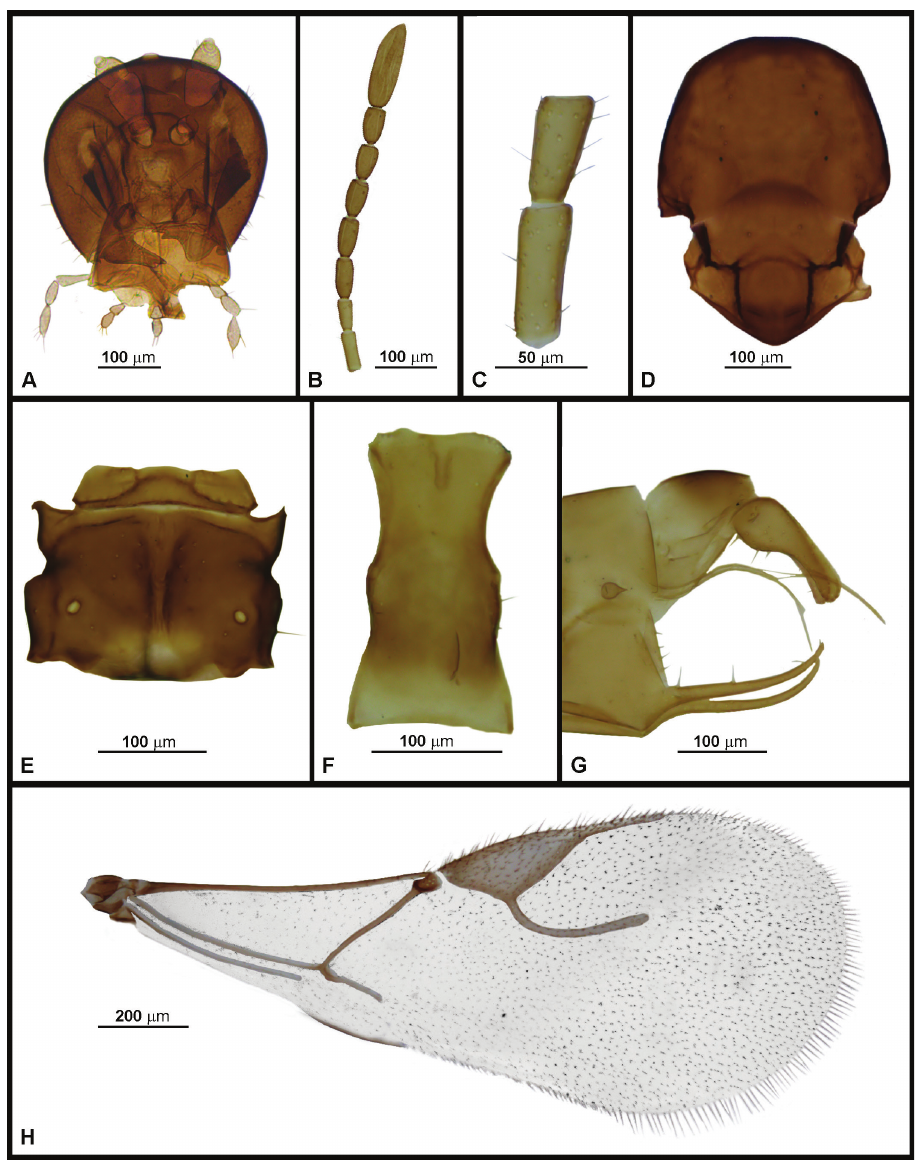
Figure 1. Trioxys depressus sp. nov., female: A head B antenna C flagellomeres 1–2 D mesoscutum E propodeum F petiole G ovipositor sheath and prongs H fore